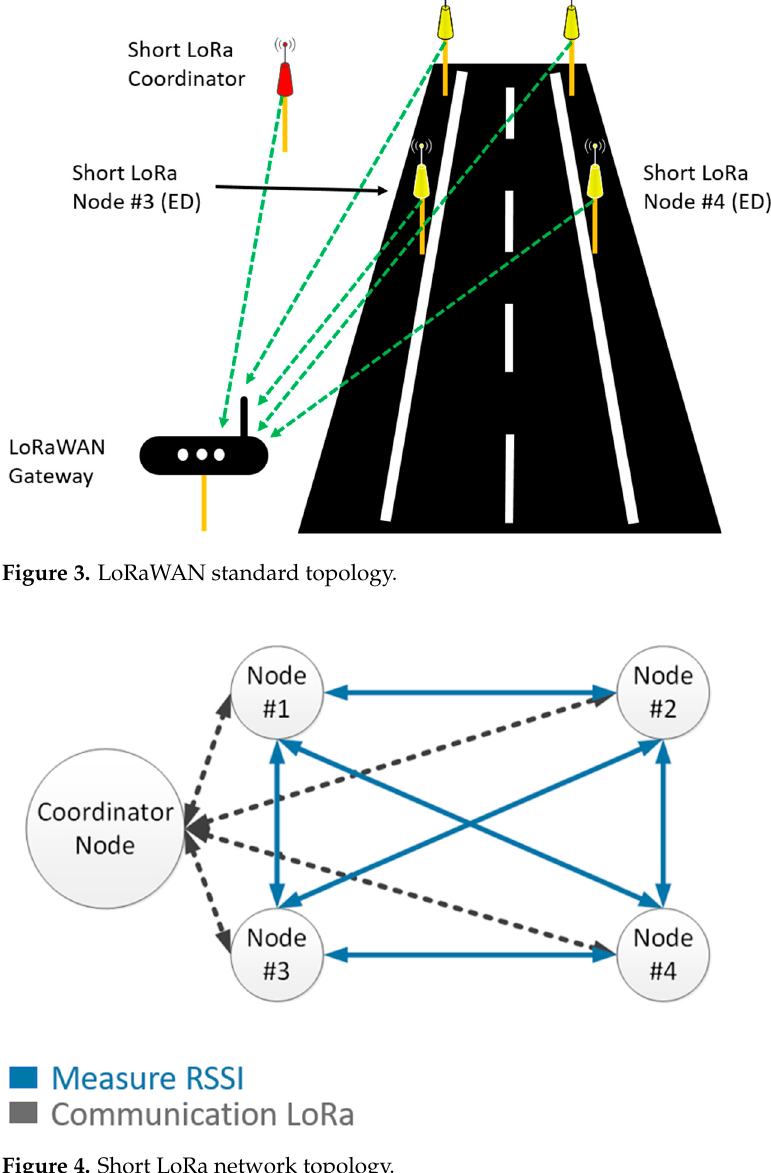
Figure 4. Short LoRa network topology.